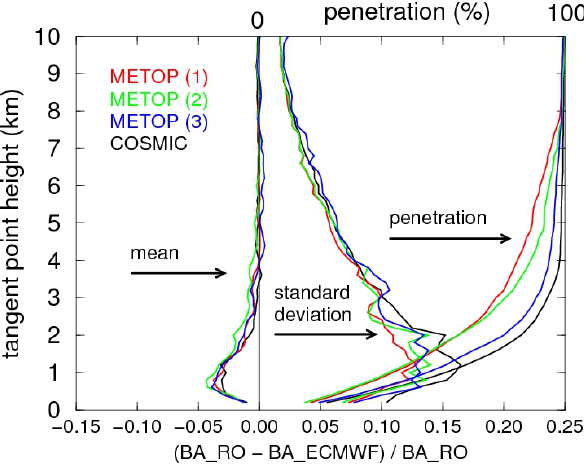
Fig. 25. Same as Fig. 22 but for all